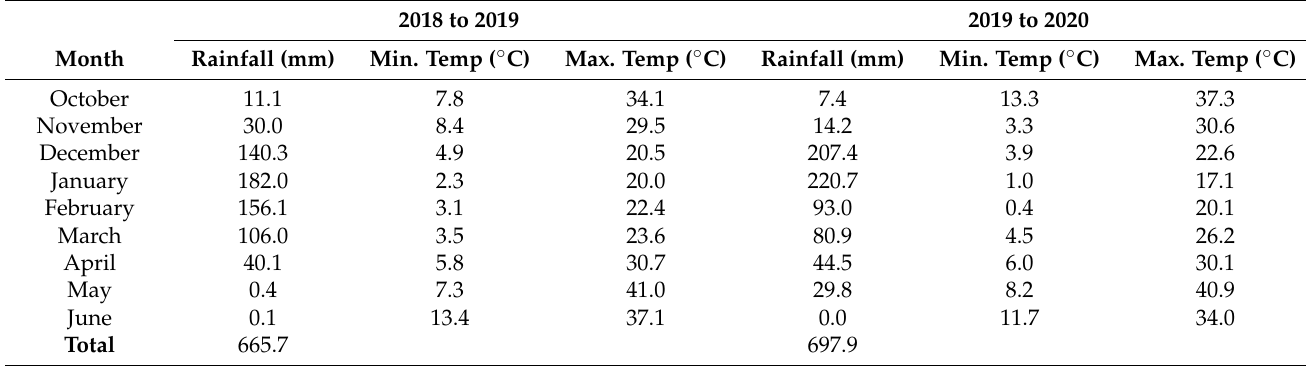
Table 1. Monthly precipitation and temperatures at the Avnei-Eitan research farm (northern Israel, altitude 375 masl, 32 ◦ 81 (cid:48) 64 (cid:48)(cid:48) N 35 ◦ 76 (cid:48) 28 (cid:48)(cid:48) E) during 2018–2019 and 2019–2020 growing seasons (Israeli Meteorological